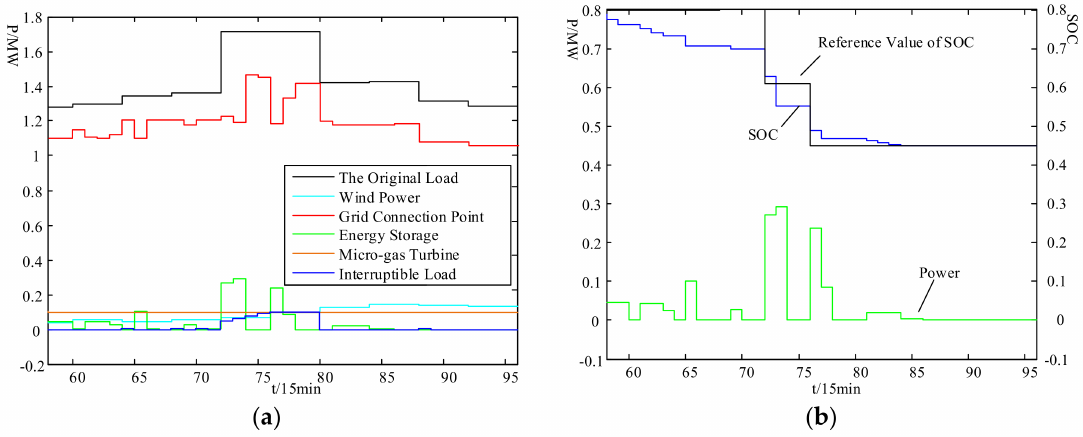
Figure 11. Results of intra-day optimal dispatch with Strategy 1: ( a ) Power curves of each device; ( b ) state of energy storage.